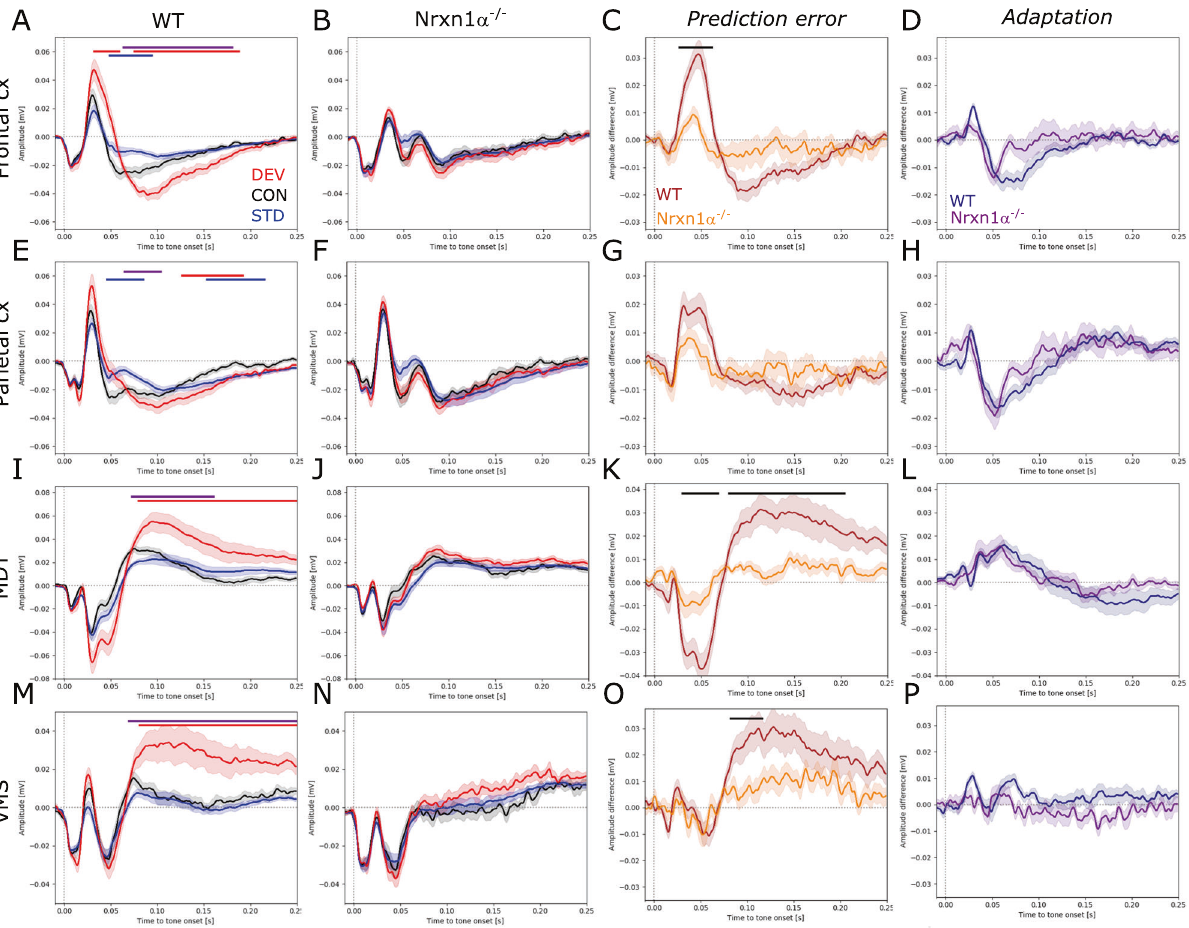
Fig. 4 Auditory event-related potentials and mismatch responses. A , E , I , M Auditory-evoked potentials in the frontal cortex, parietal cortex, mediodorsal thalamus (MDT) and ventromedial striatum (VMS) of wildtype ( N = 12) and B , F , J , N Nrxn1 − / − rats ( N = 15). Responses to the deviant tone depicted in red, to the control tone in black and to the standard tone in blue. C , G , K , O Difference waveforms between responses to the deviant and the control tone to reveal the prediction error, and D , H , L , P difference waveforms between responses to the control and to the standard tone to assess adaptation. Data displayed as mean + SEM and tested with paired or unpaired CBPT. Colored bars (red: deviant vs. control; blue: standard vs. control; violet: deviant vs. standard; black: WT vs. Nrxn1 α − / − ) above the graphs represent clusters with statistically signi fi cant differences.